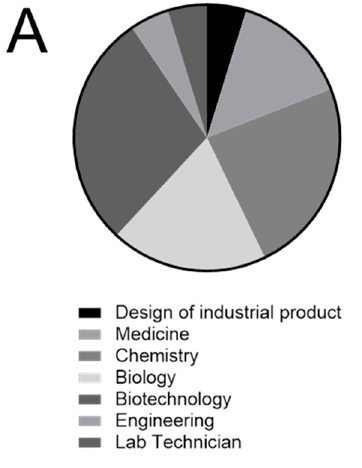
Table 1. Level of experience in handling microfluidic supports of volunteers enrolled in Pilot study 1. Previous Pipetting in Bench Work Experience of the 6 Previous Age Sex Experience Micropipetting Months (Months) (Months)